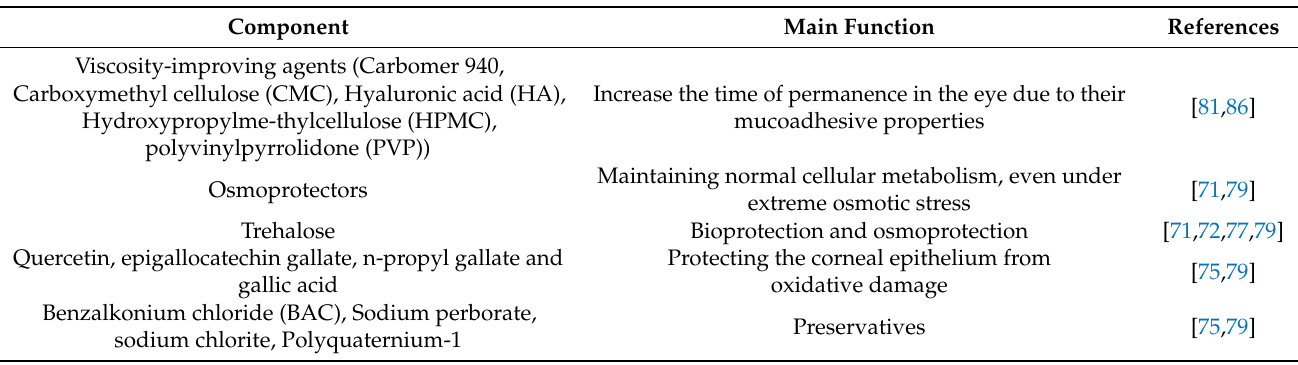
Table 2. Main components and functions of artificial